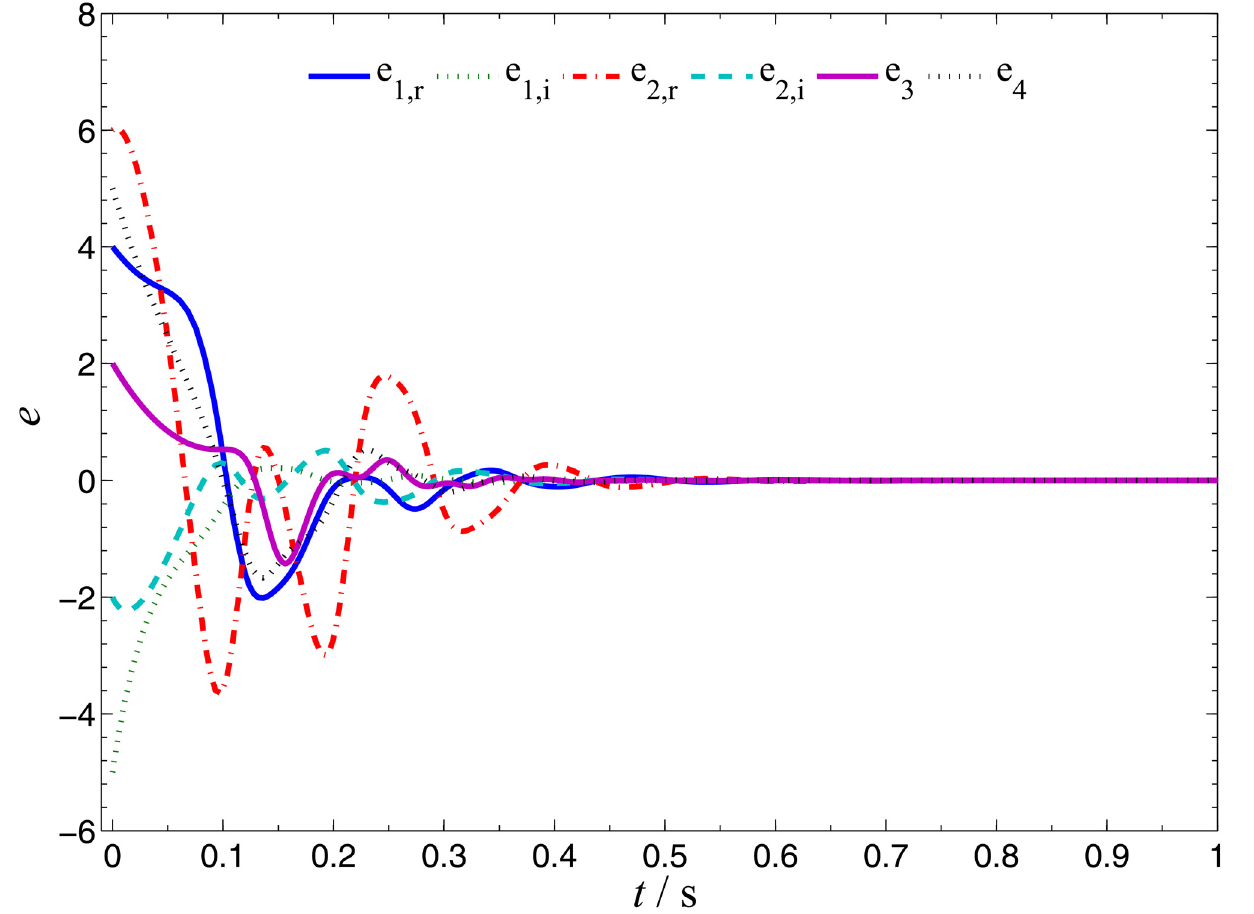
Fig 8. CGS errors of systems (19) and